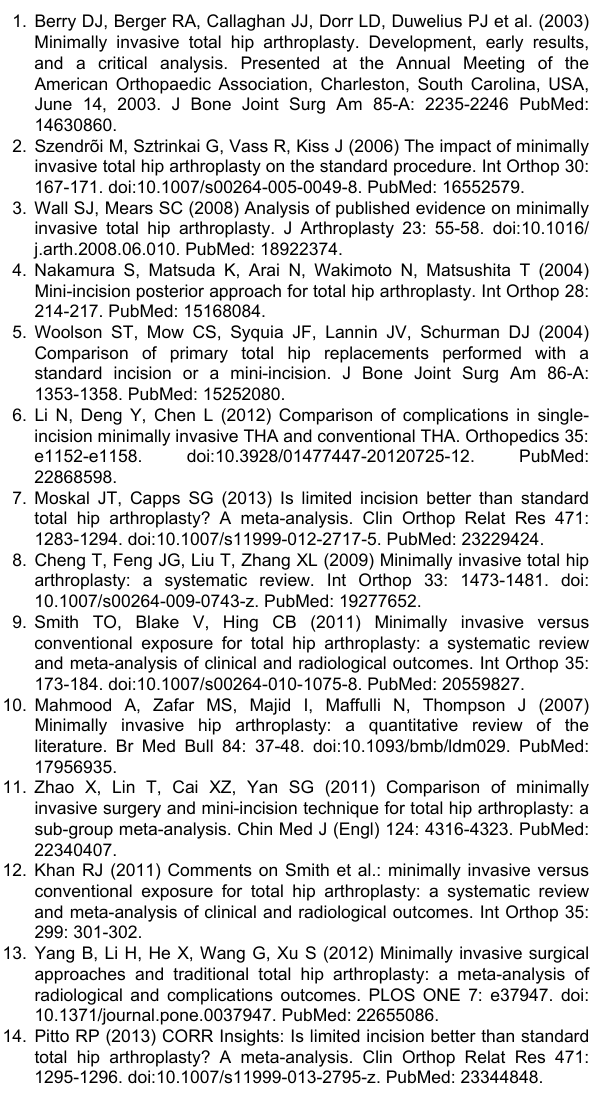
Table S1. Cochrane Collaboration’s tool for assessing risk of bias.